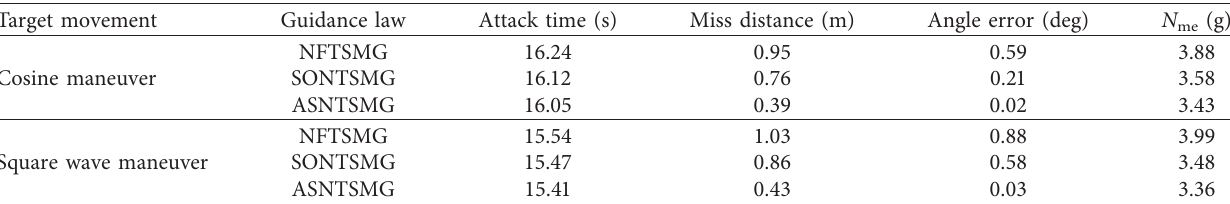
Figure 6: Missile overload. (a) Target cosine. (b) Target square wave motion. Table 1: Simulation results of different guidance